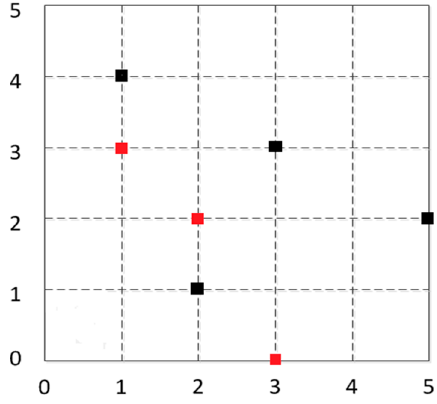
Figure 22. Experimental distribution map of location algorithm.